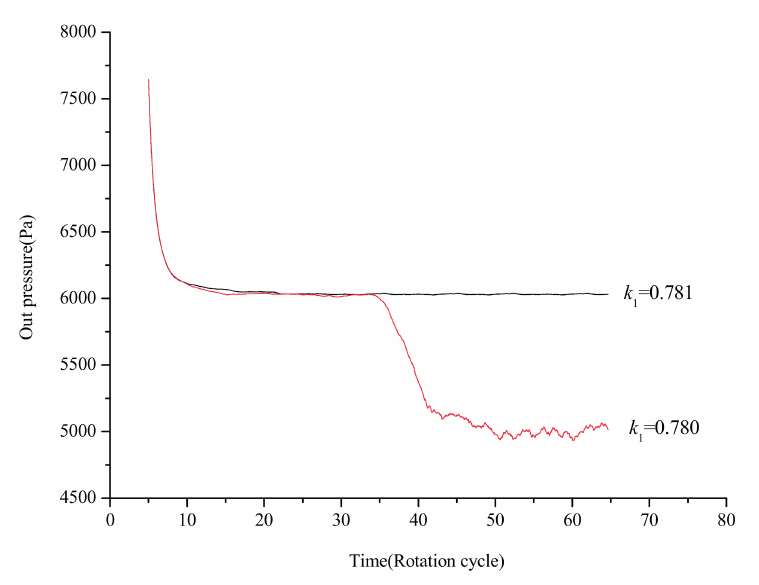
Figure 4. The history of outlet pressure on two valve coefficients.